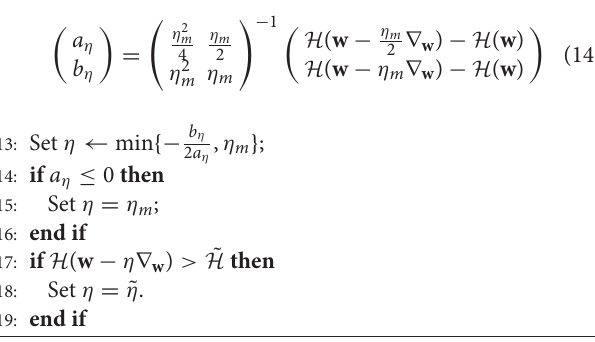
Algorithm 2. For all channels, searching for f min and f max